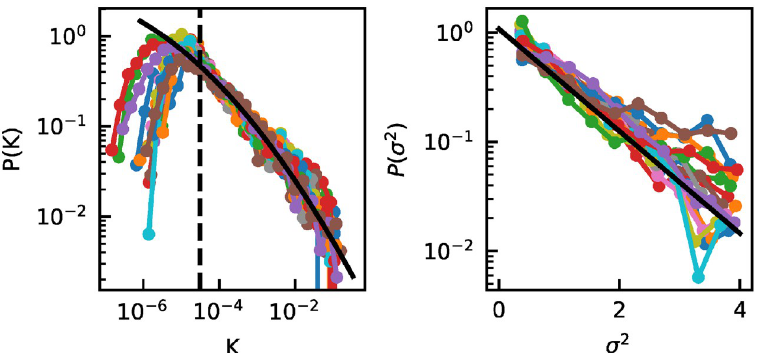
Fig 1. Parametrization of the model. A) Distributions of K for each individual. Colored points and lines are normalized histogram of the data. The black line is a maximum likelihood fit to a truncated lognormal distribution, with truncation at 10 − 4.5 , of the values from all individuals (parameters of fitted lognormal: μ = − 19.85, s = 4.93). The dashed line refers to the cutoff due to finite sampling: below this value the effect of sampling produces deviation from the Lognormal distribution; B) Distribution of σ 2 for each individual (colored points and lines are normalized histogram of the data). The black line is a maximum likelihood fit to an exponential distribution of the values from all individuals (mean = 0.93). All individuals are characterized by the same distributions of carrying capacity K and variability σ